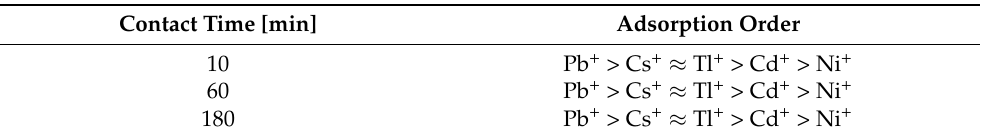
Table 8. Adsorption selectivity series for PCT from single-element solutions with a heavy metal content of 10 ng · g − 1 .